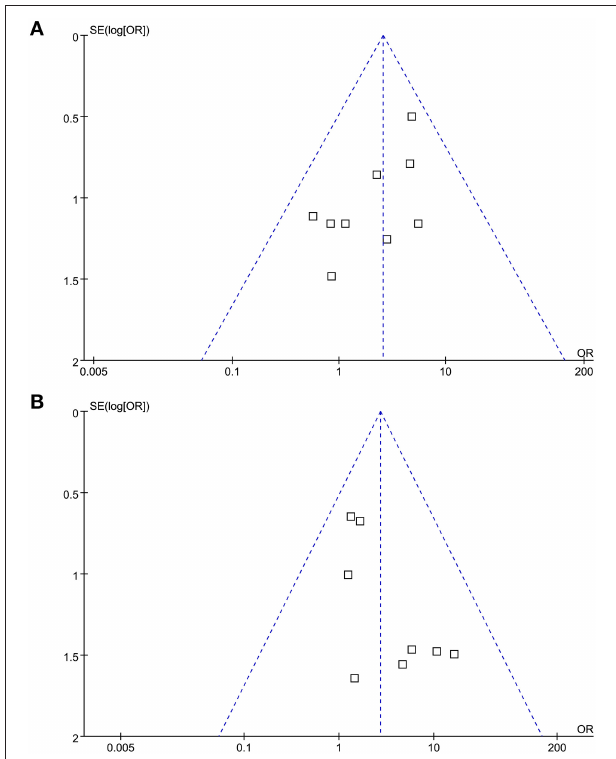
FIGURE 4 | Funnel plots for the meta-analysis evaluating the risk of CTEPH in patients with and without previous VTE, and in patients with provoked and unprovoked PE; (A) comparing risk of CTEPH in patients with and without previous VTE; and (B) comparing risk of CTEPH in patients with unprovoked and provoked